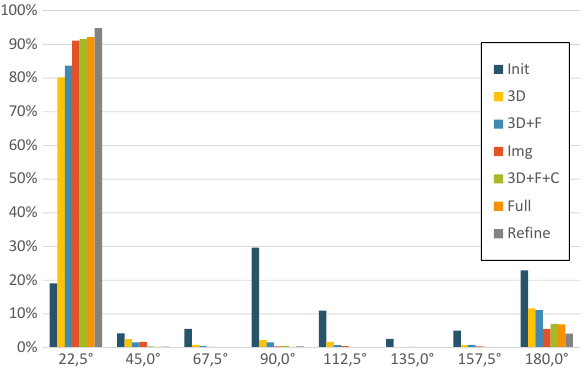
Figure 4. Cumulative histogram of absolute differences between estimated and reference orientations ( easy level).